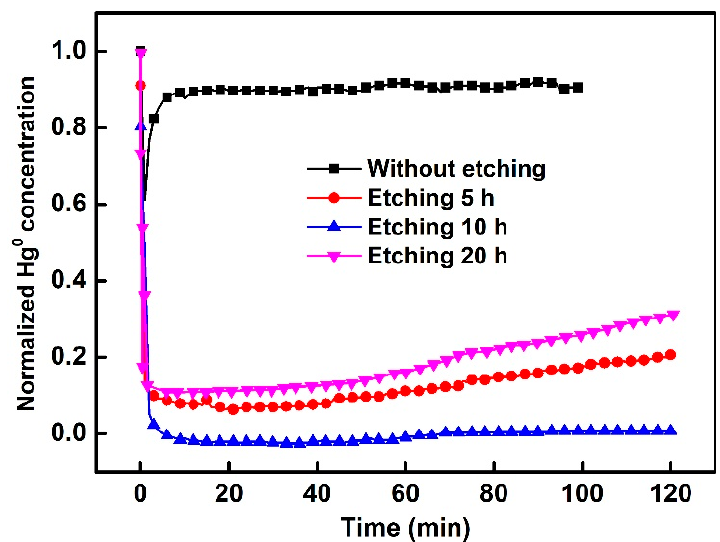
Figure 6. Hg 0 removal performances of S-C with different etching times.